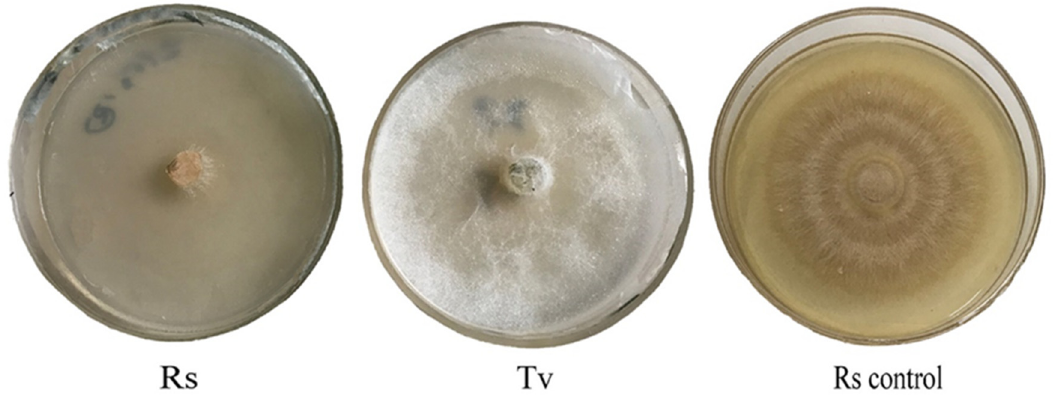
Figure 5. Inhibitory effect of volatile metabolites of T. virens ZT05 on R. solani (Rs, R. solani ; Tv, T. virens ZT05; and Rs control, R. solani control.).